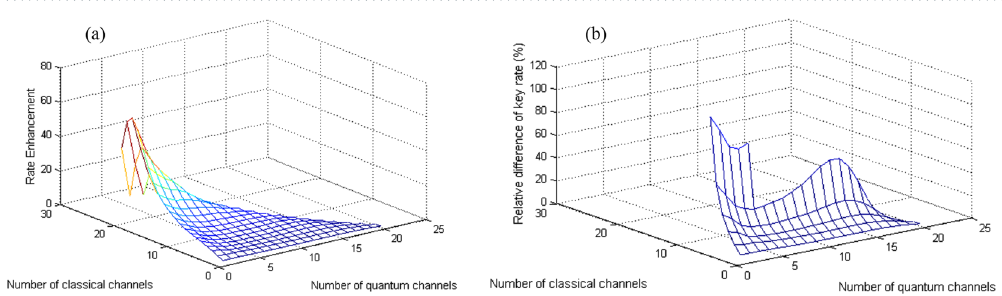
Figure 5. Rate enhancement at (a) L = 50 km and (b) L = 65 km for the full-duplex system at R th =